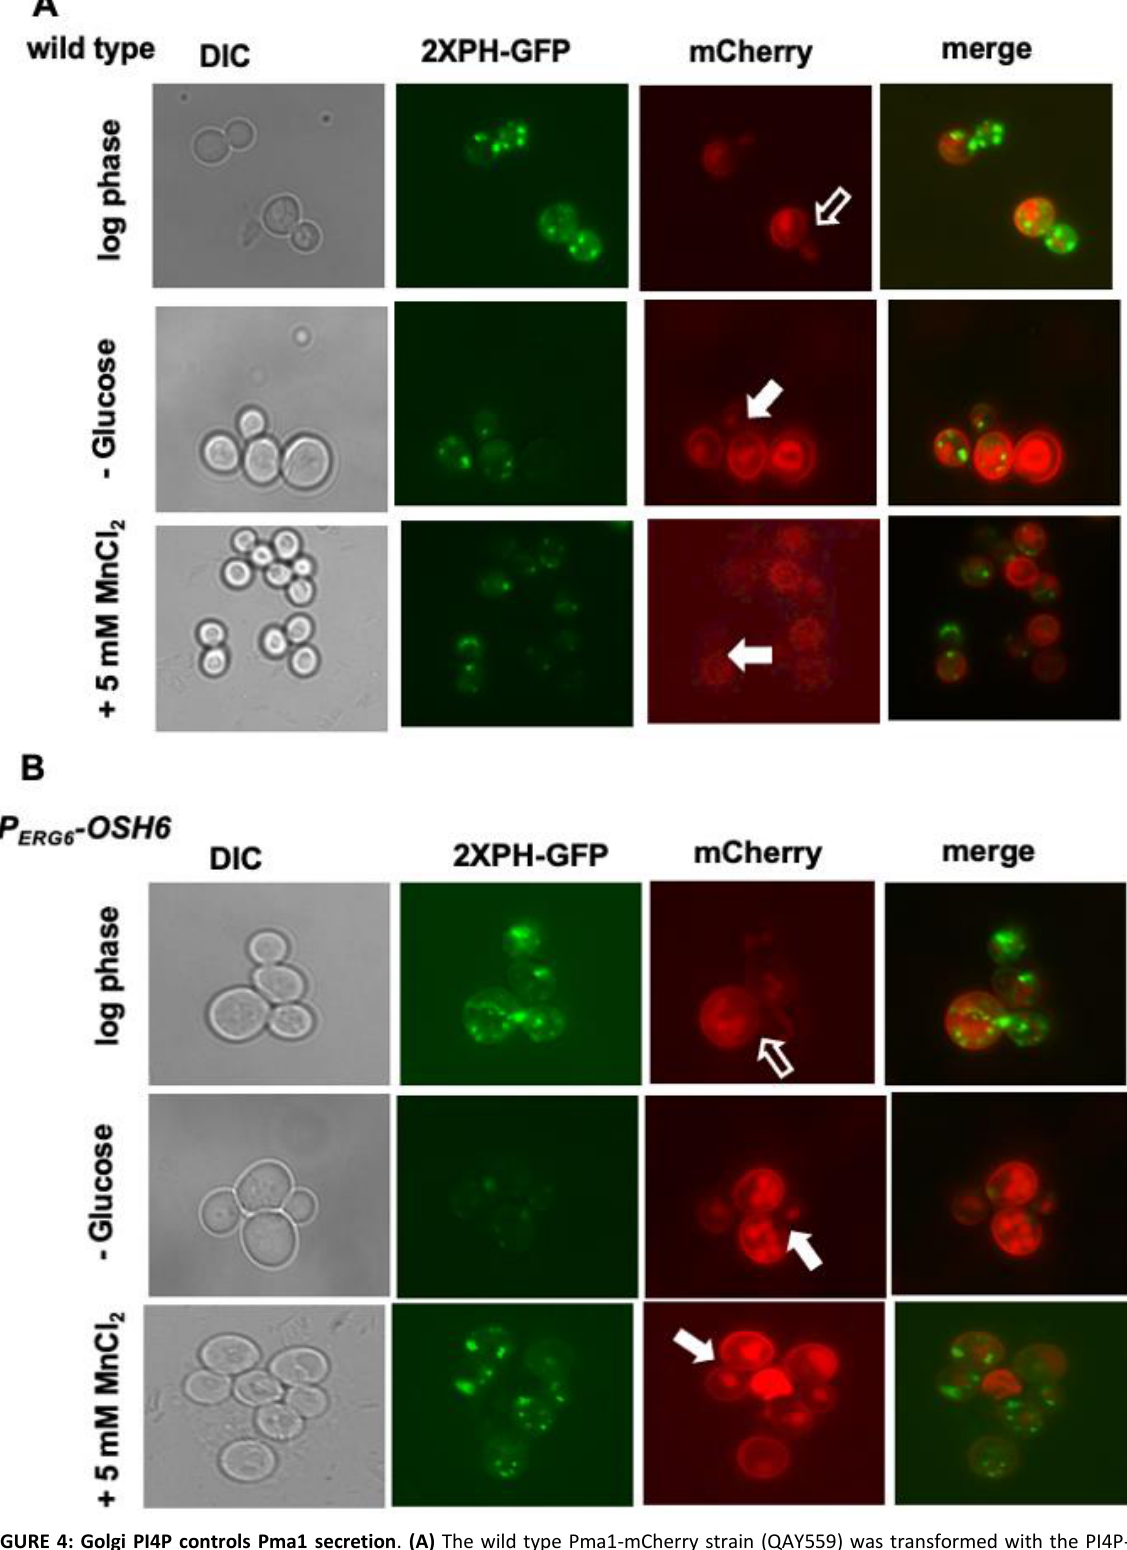
FIGURE 4: Golgi PI4P controls Pma1 secretion . (A) The wild type Pma1-mCherry strain (QAY559) was transformed with the PI4P-labeling (2XPH-GFP) plasmid. Transformants were grown in SC-URA with 2% glucose to early log phase (first row), and then starved for glucose for 30 minutes (second row) or treated with 5 mM of MnCl 2 for 30 min (third row) and photographed. (B) The P ERG6 - OSH6 Pma1mcherry strain (FTY520) was transformed with the PI4P-labeling (2XPH-GFP) plasmid. Transformants were grown in SC-URA to mid-log phase (first row), and then starved for glucose for 30 minutes (second row), or treated with 5 mM of MnCl 2 (third row). Hollow arrows point to mother-bud neck where the Pma1 signal is not as bright as other PM of its mother cell. Solid arrows point to small or mid-size budded cells with homog- enously distributed Pma1 on the PM of the mother